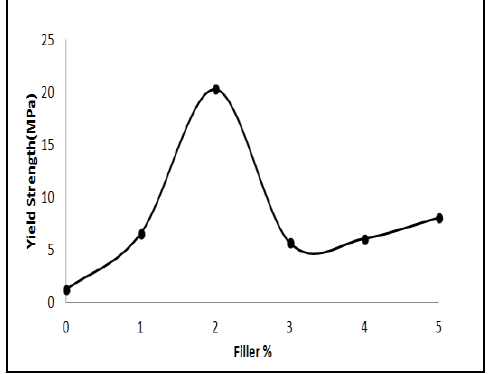
Fig.13: Yield strength with filler for